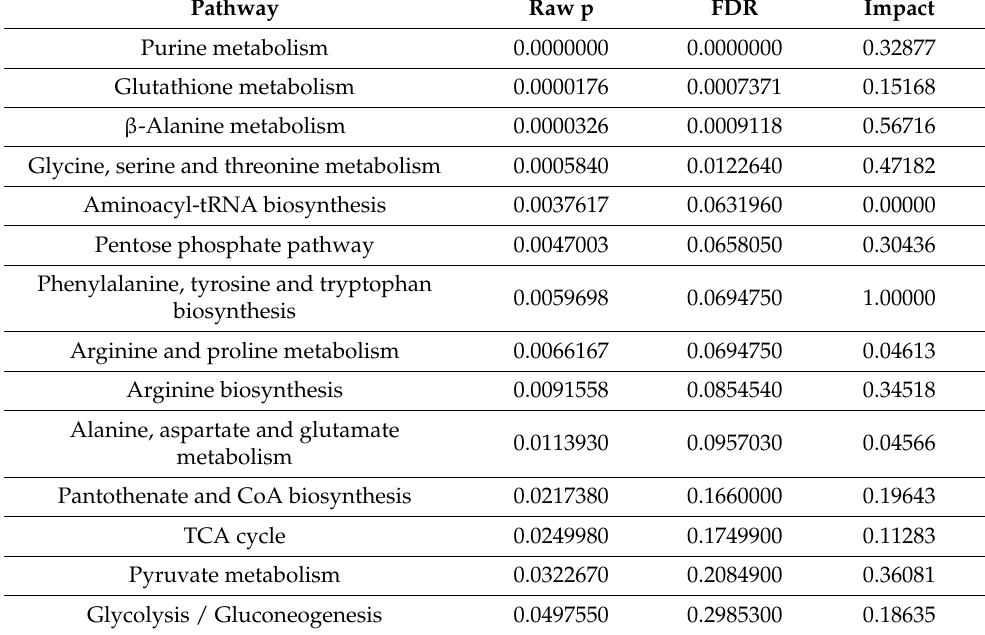
Table 2. Metabolic pathways with significant changes.